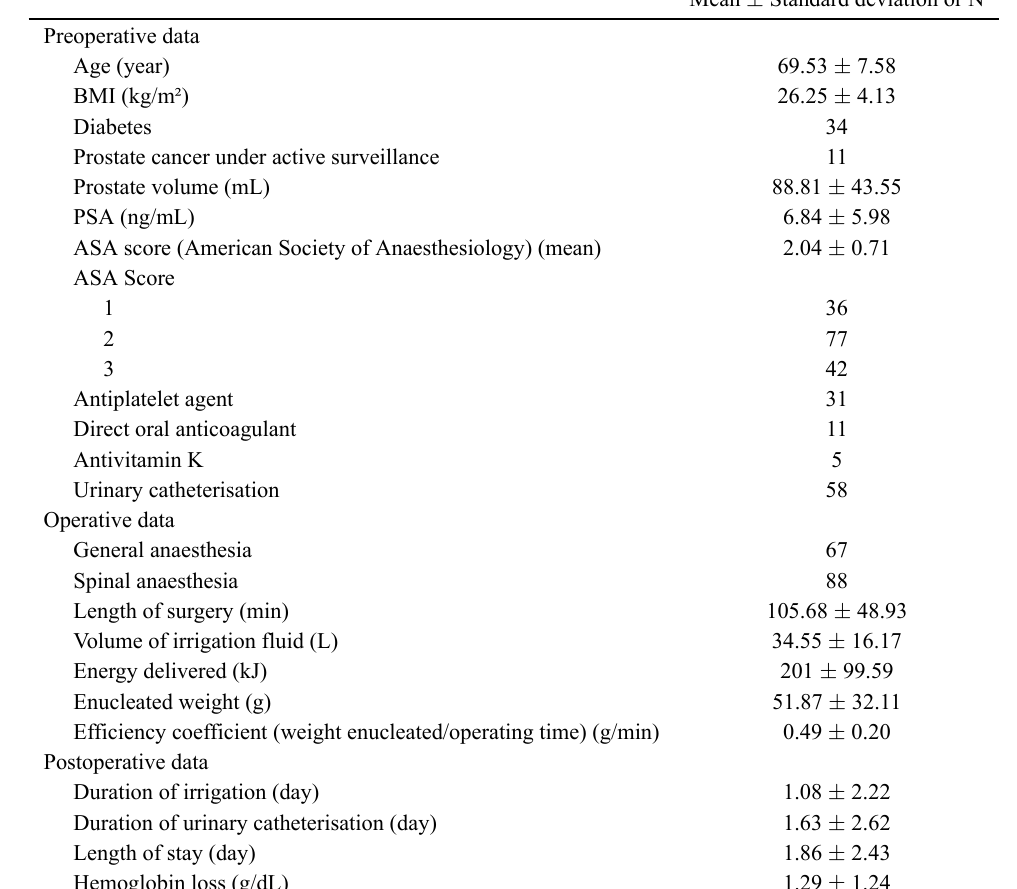
Table 1. Patients’ characteristics and urinary function.